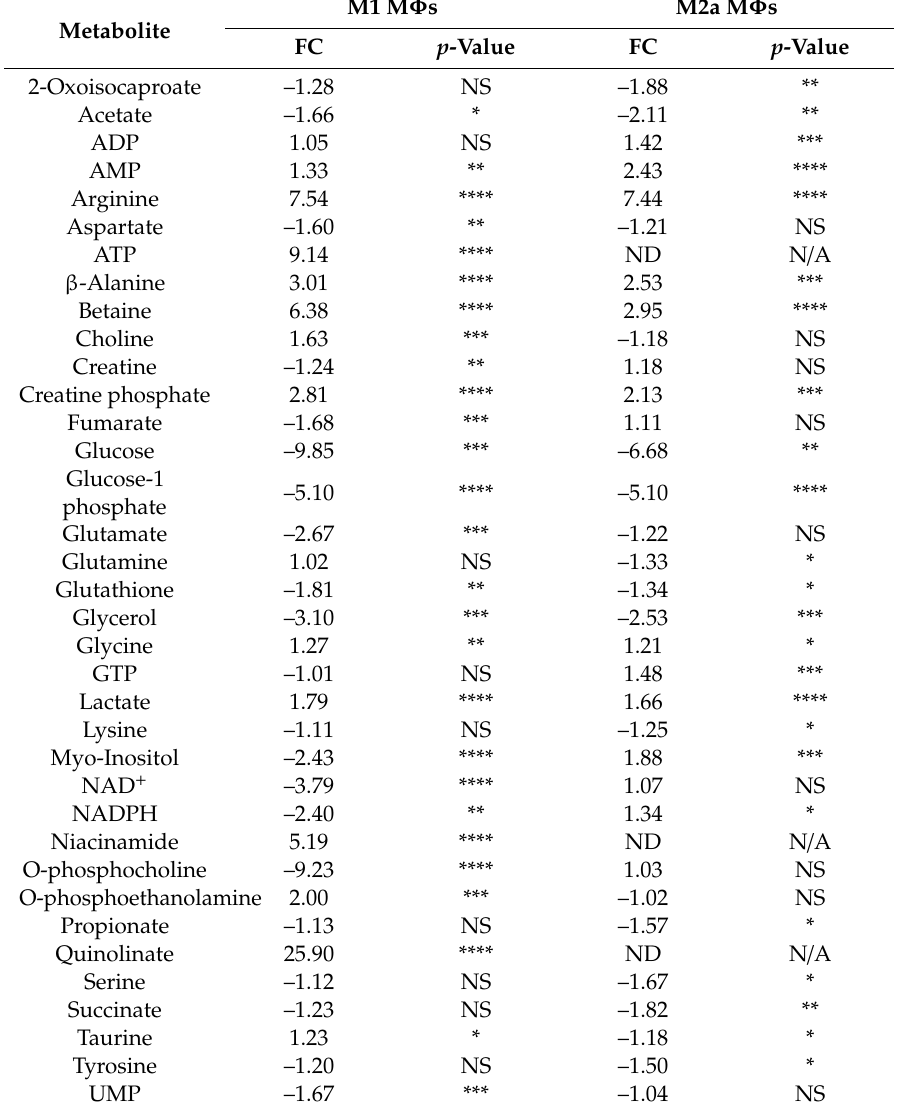
Table 1. Discriminatory metabolites in intracellular extracts associated with